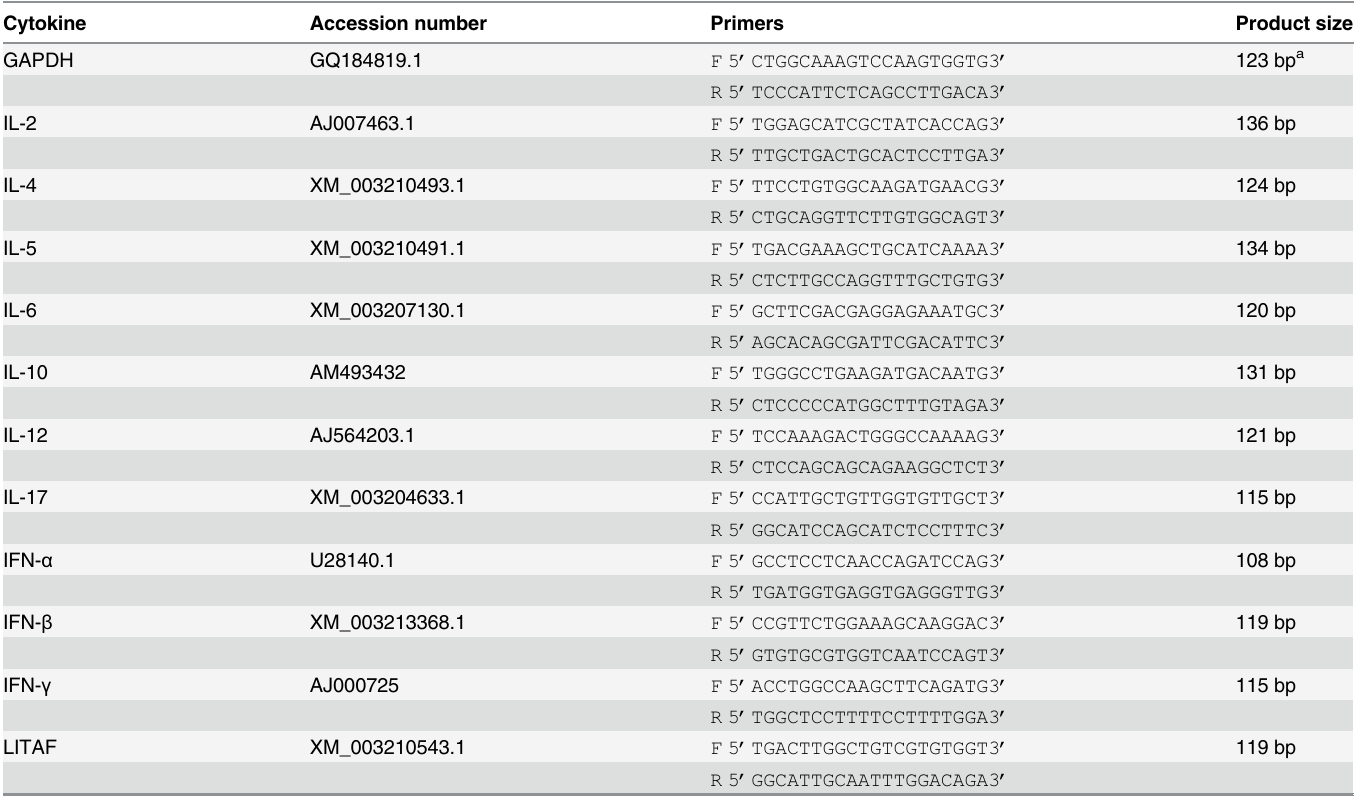
Table 1. List of cytokine genes and the primers used for RT-PCR amplification.